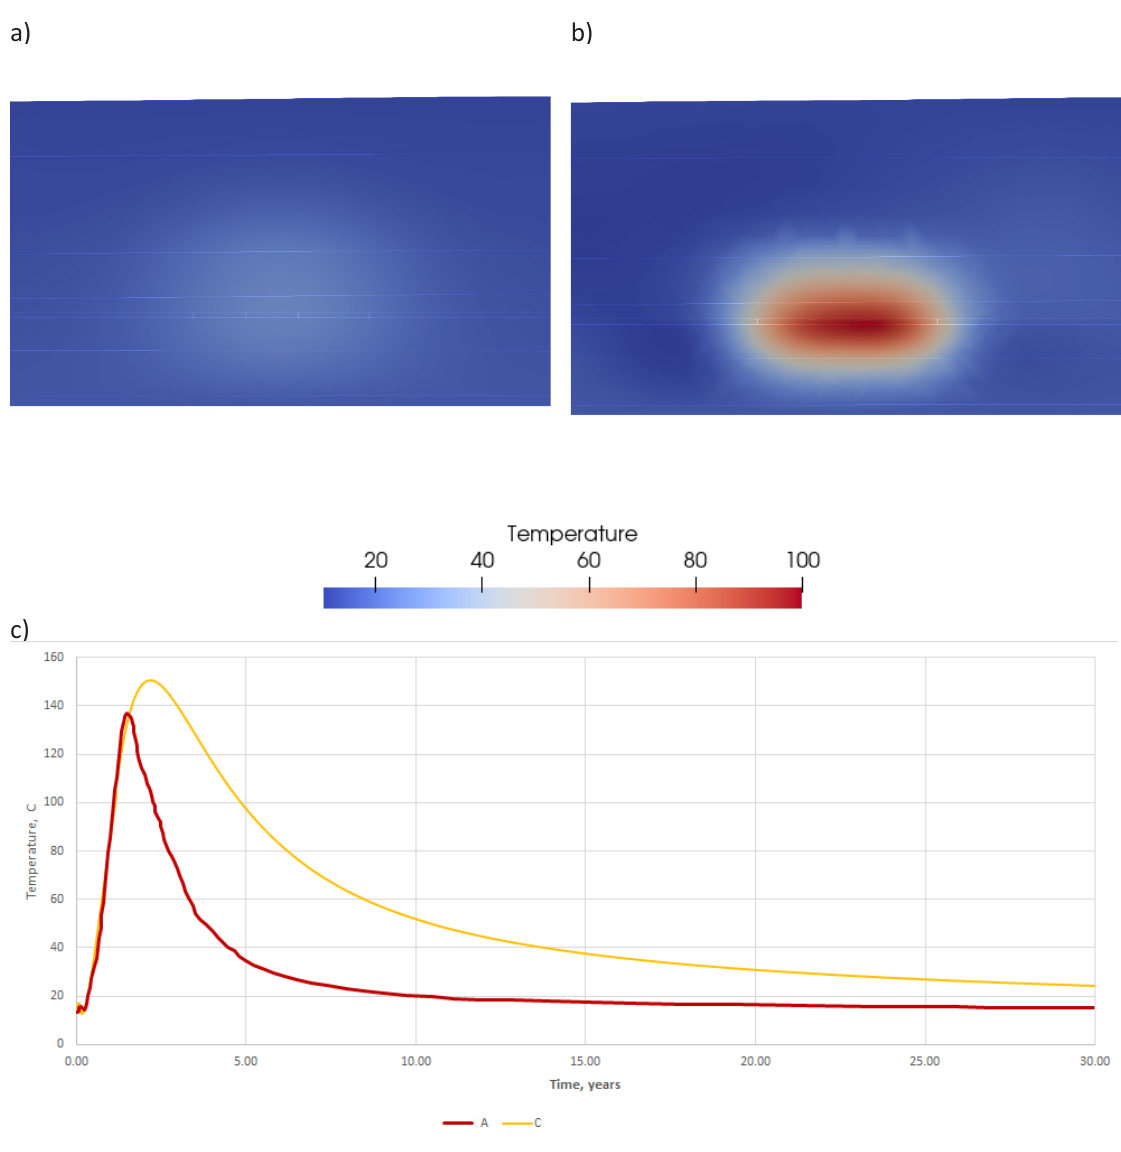
Figure 15: A) temperature (°C) after 6 years when thermal parameters of water vapour were accepted in volume, where phase transition occurred, b) temperature in case, where no phase transition in the pores was modelled c) time course of temperature in both cases at point x = 71,5 m, y = 75,0 m, z = 63